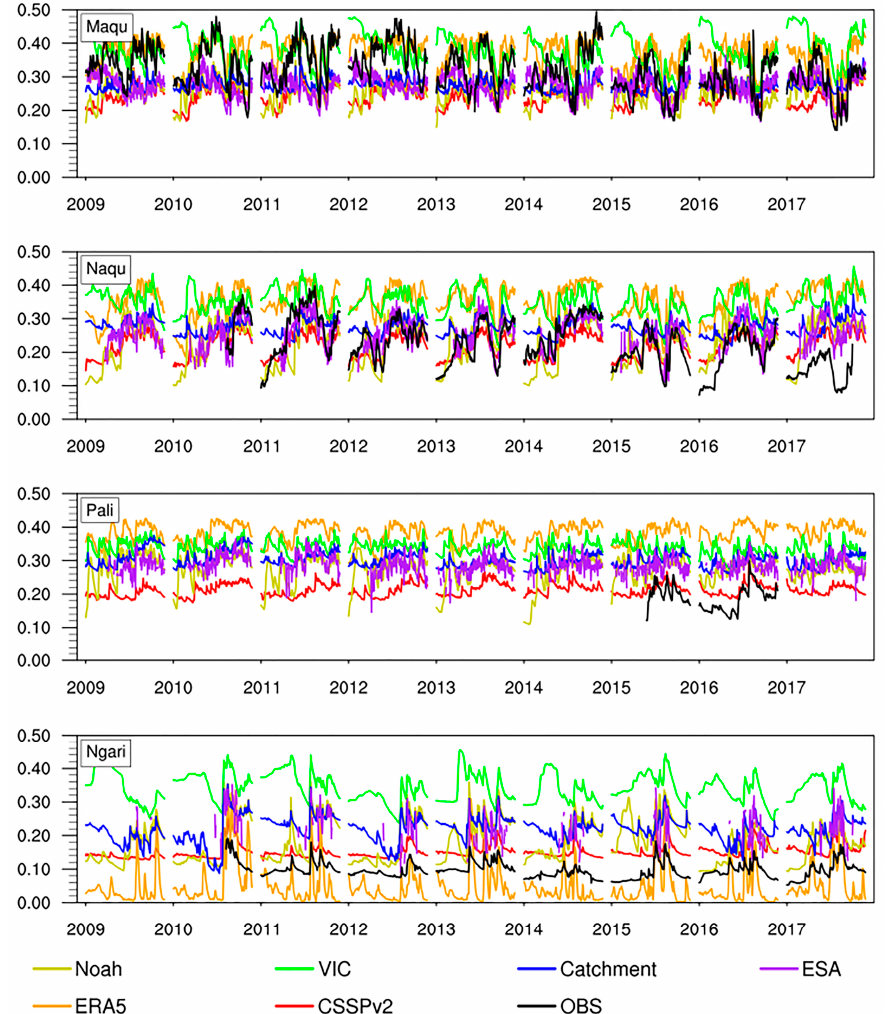
Figure 4. Time series of soil moisture averaged in four sub-regions for observation and different